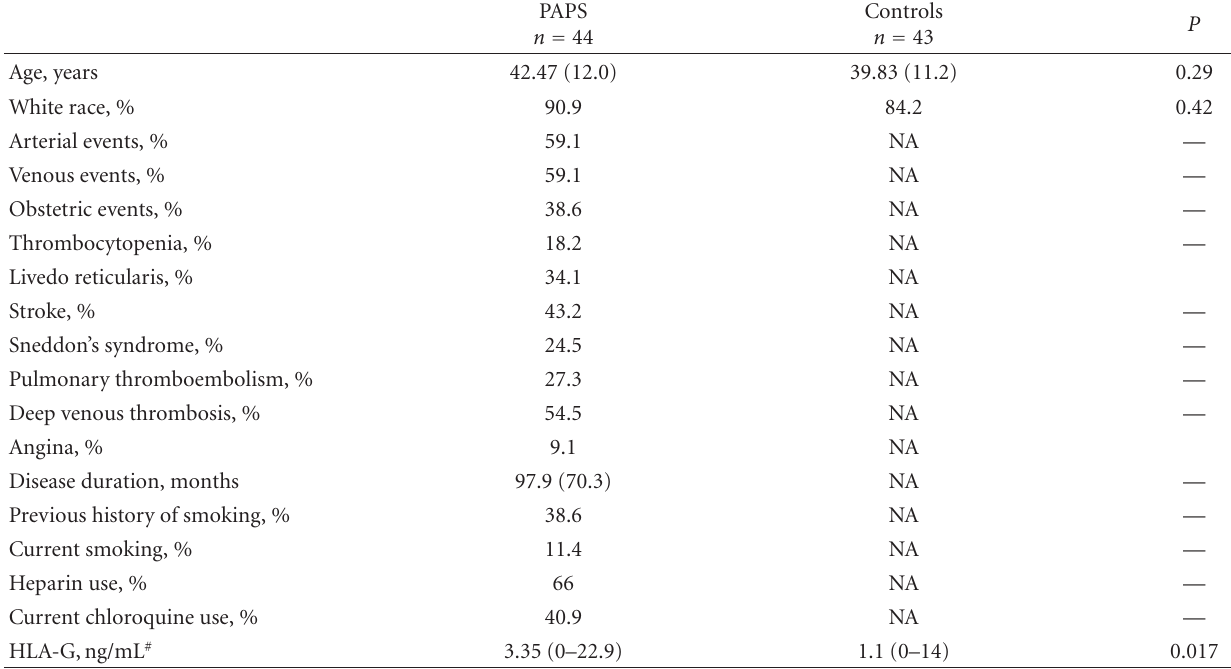
Table 1: Demographic, anthropometric, clinical, and laboratory features of the 44 PAPS patients and 43 healthy controls that provided samples for the measurement of HLA-G levels.